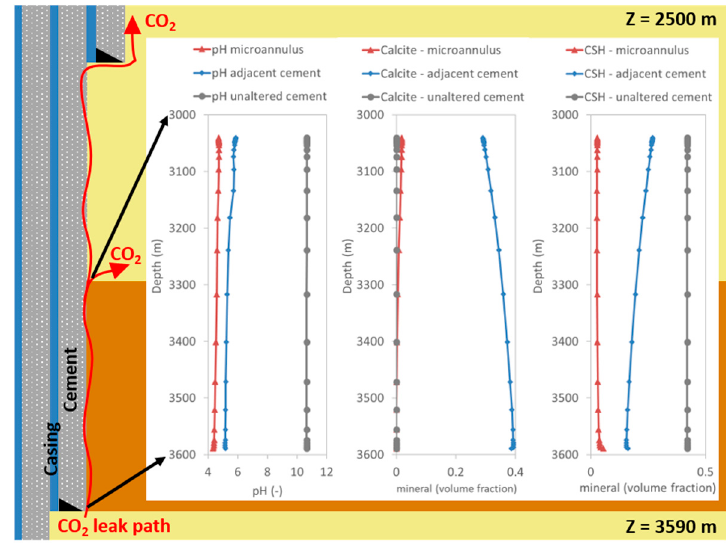
Figure 3. The background shows a schematic overview of the model with a cement sheet, the microannulus leak path and the adjacent formation rock. The pH, calcium silicate hydrate (CSH) content and calcite content after two years of CO 2 leakage are plotted for the lower part of the annulus adjacent to the caprock.